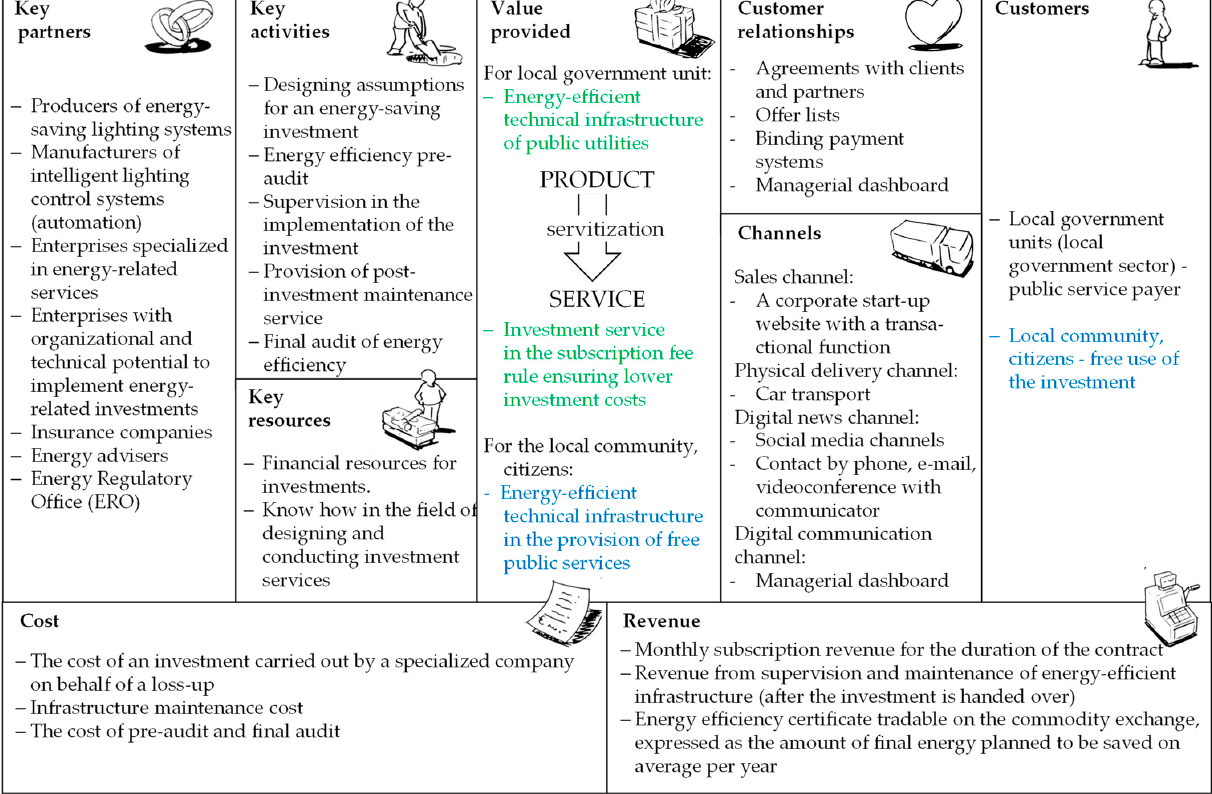
Figure 6. A start-up business model that provides an investment service in the subscription fee formula. Source: Own study based on the template Business Model Canvas [69].